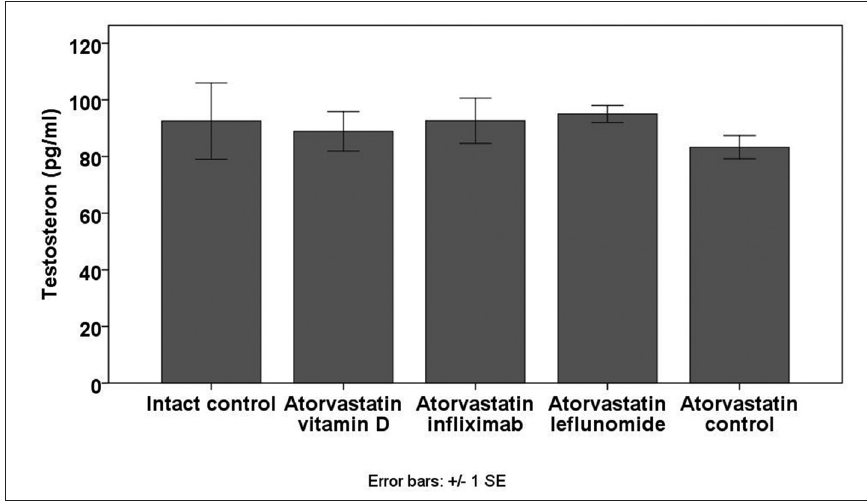
Figure 1. Alterations in serum testosterone concentrations of groups. “Intact control” refers to the rats in the vehicle group. An improved but insignificant induction in testosterone levels after administration of vitamin D, infliximab, or leflunomide was seen in rats under atorvastatin